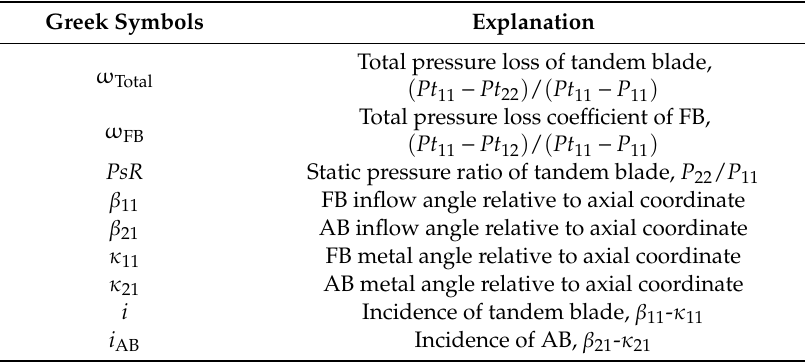
Table 2. Aerodynamic evaluation